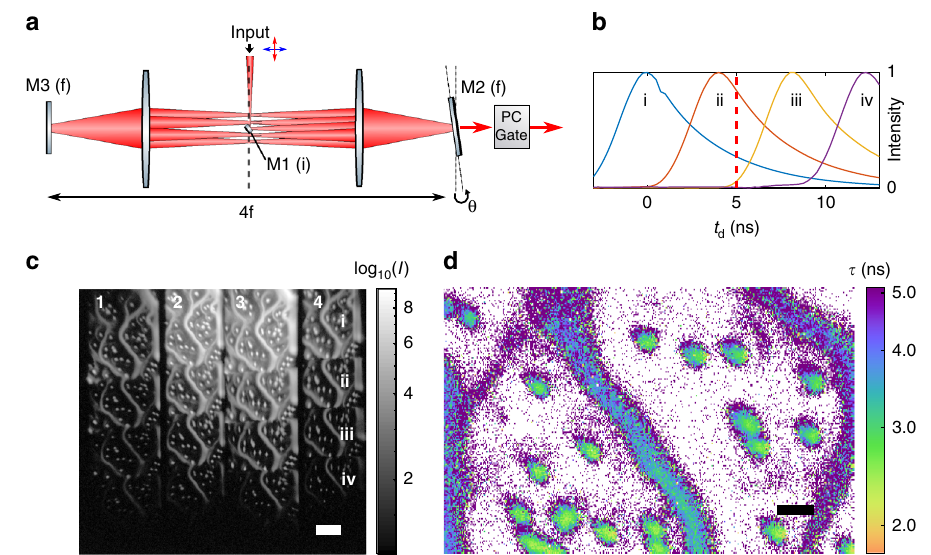
Fig. 5 Multi-frame nanosecond imaging with a cavity time-to-space converter. a Externally gated, tilted mirror 4 f re-imaging cavity. Image input is on small in-coupling mirror M1 in an image plane (i). M2 is tilted at a diffraction plane (f), spatially offsetting the images at the M1 plane each pass. Each round trip, images are passively out-coupled through partially transmissive mirror M2. b Normalized image intensities for four output images from the cavity showing a 4 ns round trip delay. c Cavity output on camera (CMOS) shows 4 x 4 images output from the PC analyzer. The columns are numbered 1-4 in analogy to Fig. 1, and the rows (i – iv) give the outputs from the fi rst four cavity round trips (scale bar 50 μ m). The sample is a mixture of drop-cast nile red 2 μ m beads (~3.1 ns) and orange 0.1 μ m beads (4.9 ns) that form the diffuse fi laments. d The ratio of output frames (row i, column 4) and (row ii, column 4) in the gated channel at t d = 5 ns (red line in ( b )) is used for single-frame FLIM as described in the text. The two labels are readily differentiated (scale bar 10 μ